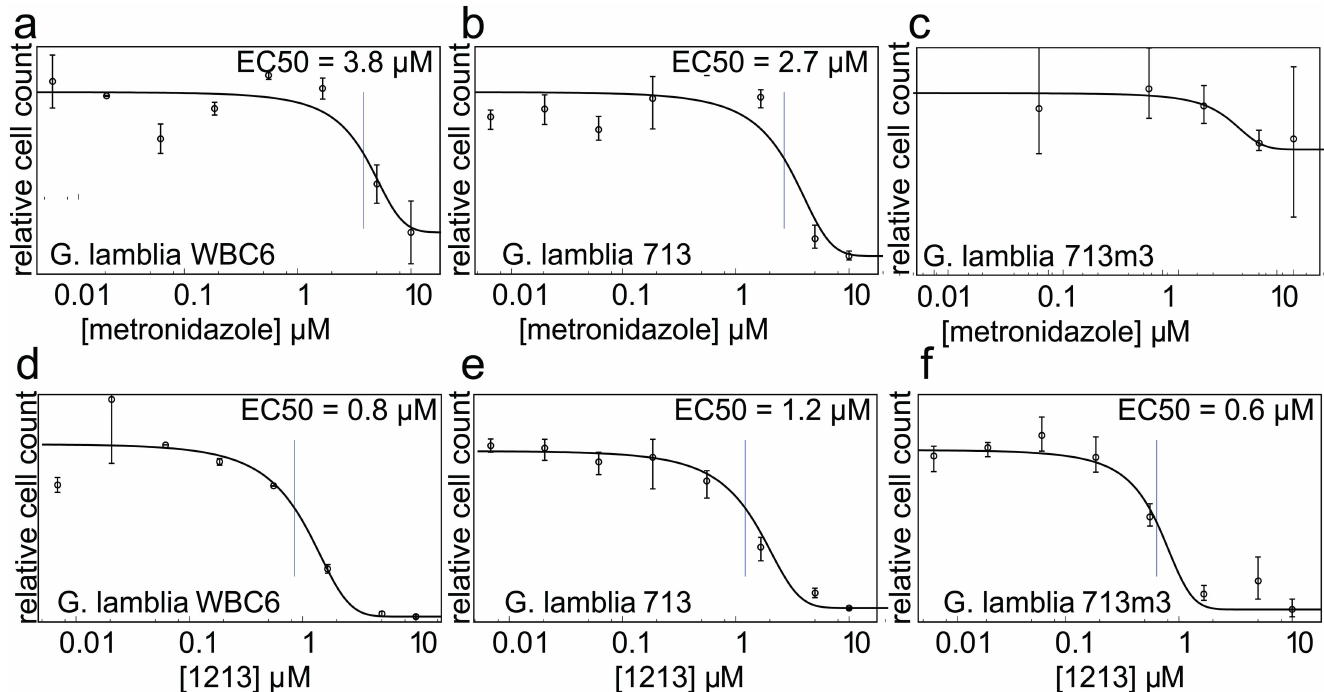
Fig 7. BKIs are effective against metronidazole-resistant Giardia cells. (a) Wild-type G . lamblia clone WBC6 and (b) clone 713 are inhibited by metronidazole (EC 50 of 3.8 μ M and 2.7 μ M, respectively), but ( c) metronidazole-resistant clone 713-M3 is not. Clones (d) WBC6 , (e) 713 and (f) 713-M3 are each inhibitedby BKI 1213 (EC 50 of 0.8 μ M, 1.2 μ M, and 0.6 μ M,